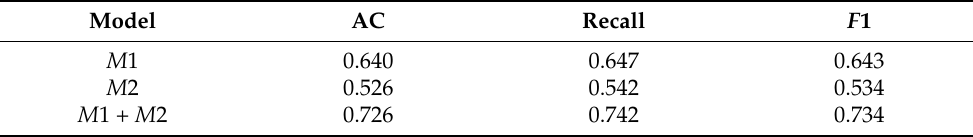
Table 3. Ablation experiment results for each